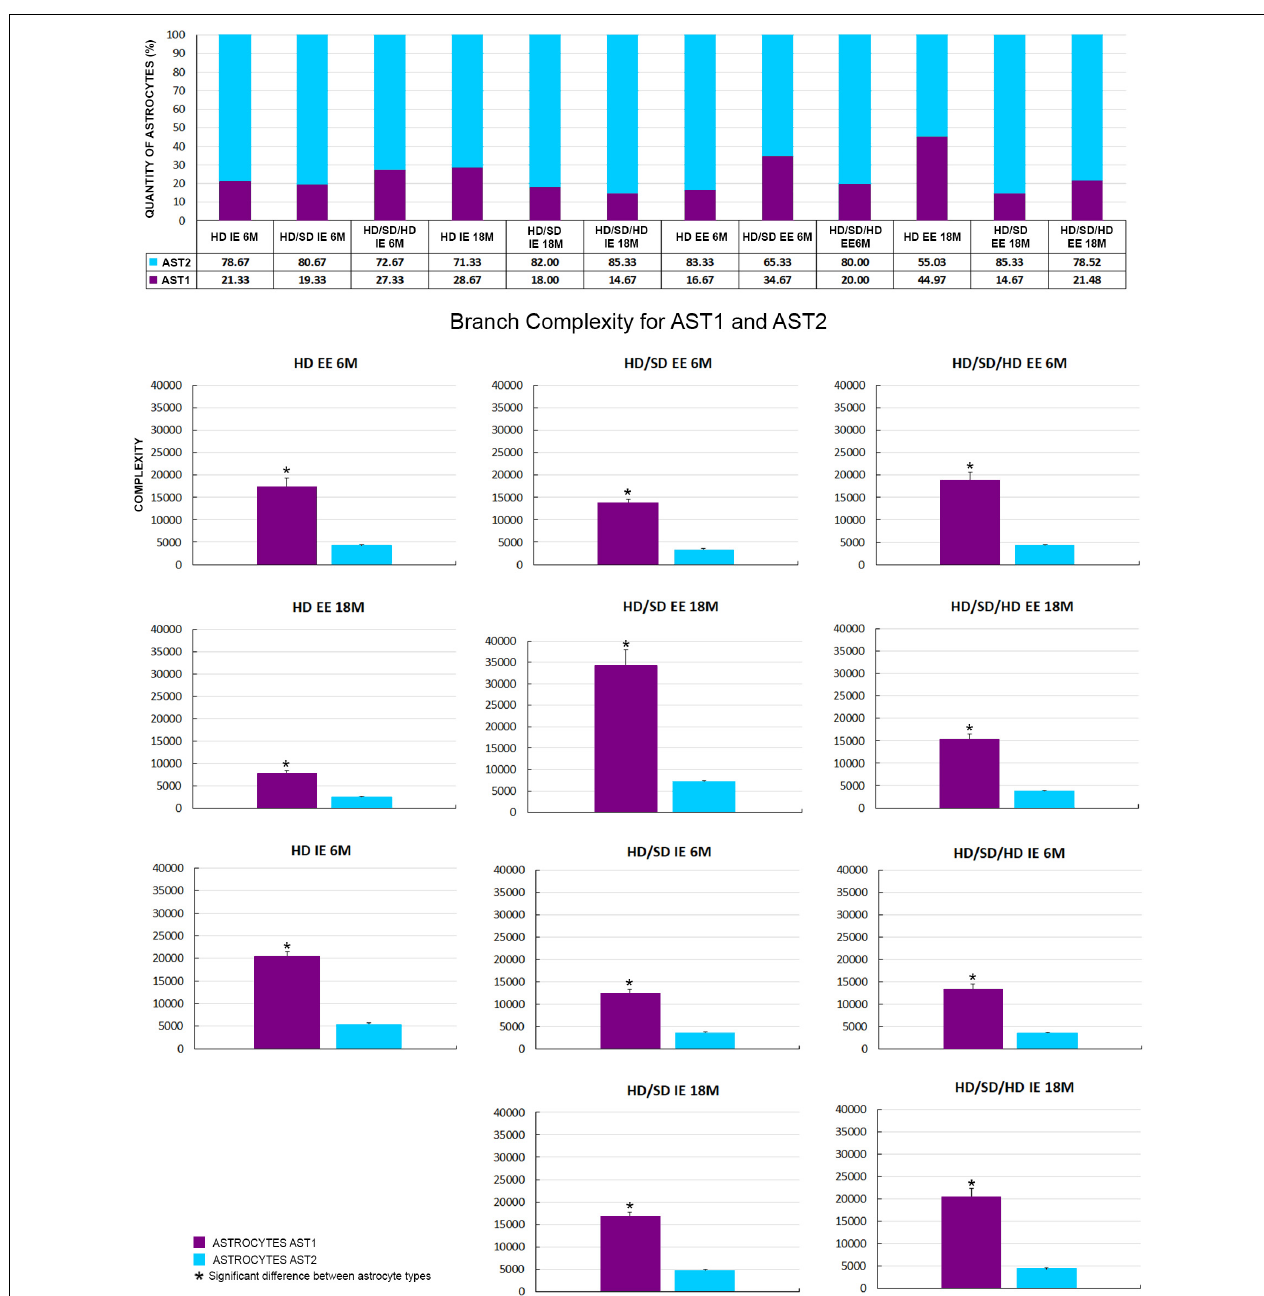
FIGURE 5 | (Top) Graphical representation of astrocyte number (absolute values and percentage) by cellular phenotype (AST1 and AST2) for each diet regime (HD, HD/SD, and HD/SD/HD), environment (impoverished – IE and enriched – EE) and age of 6 (6M) and 18 months (18M), on the top. (Bottom) Comparison of mean branch complexity values and corresponding standard errors to illustrate differences between AST1 and AST2 for all experimental groups. HD, hard diet/pellet food and SD, soft diet/powder food. (*) Indicates p < 0.05. IE, impoverished environment; EE, enriched environment; 6M, 6-month-old; 18M, 18-month-old; 9M, 9-month-old; HD, hard diet/pellet; SD, soft diet/powder food; AST1, astrocyte with high morphological complexity; AST2, astrocyte with low morphological